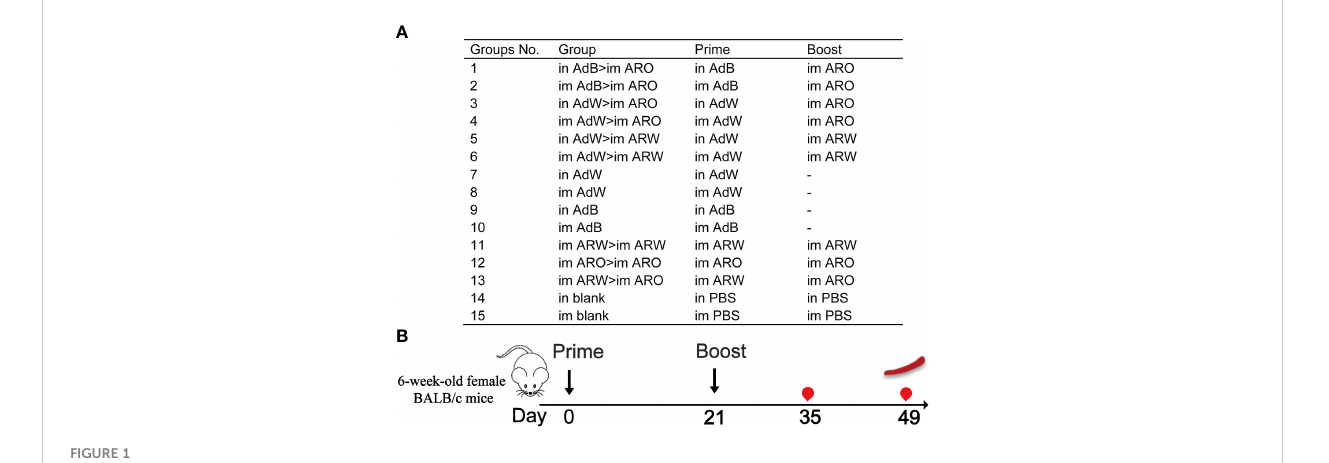
FIGURE 1 Overall scheme of the immunisation strategies and experimental timeline using female BALB/c mice. (A) Mice in 15 groups were immunised with four COVID-19 vaccines using different protocols. Dashes indicate no booster vaccination. (B) Immunisation and immunological characterisation